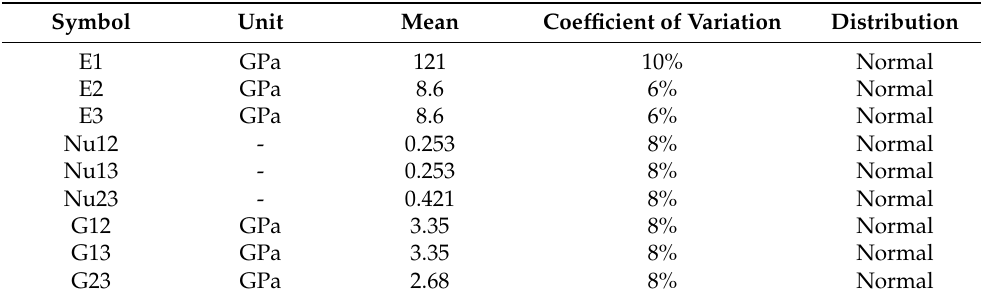
Figure 1. Finite element mesh of the composite cylindrical shell. Table 1. Statistical information of the material properties of the carbon fiber–epoxy composite material.